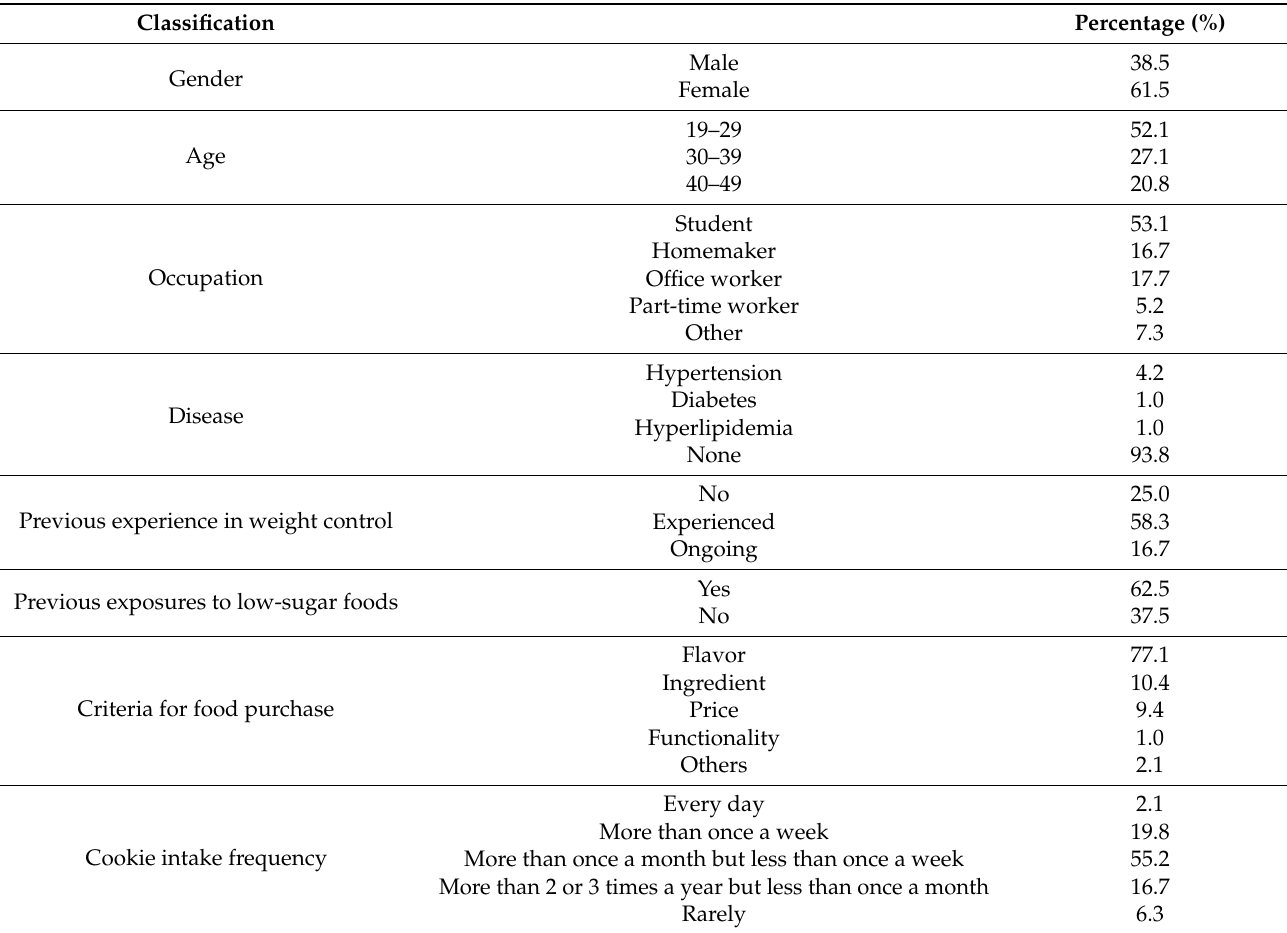
Table 5. Consumer demographic profiles and cookie-related eating habits (n = 96).